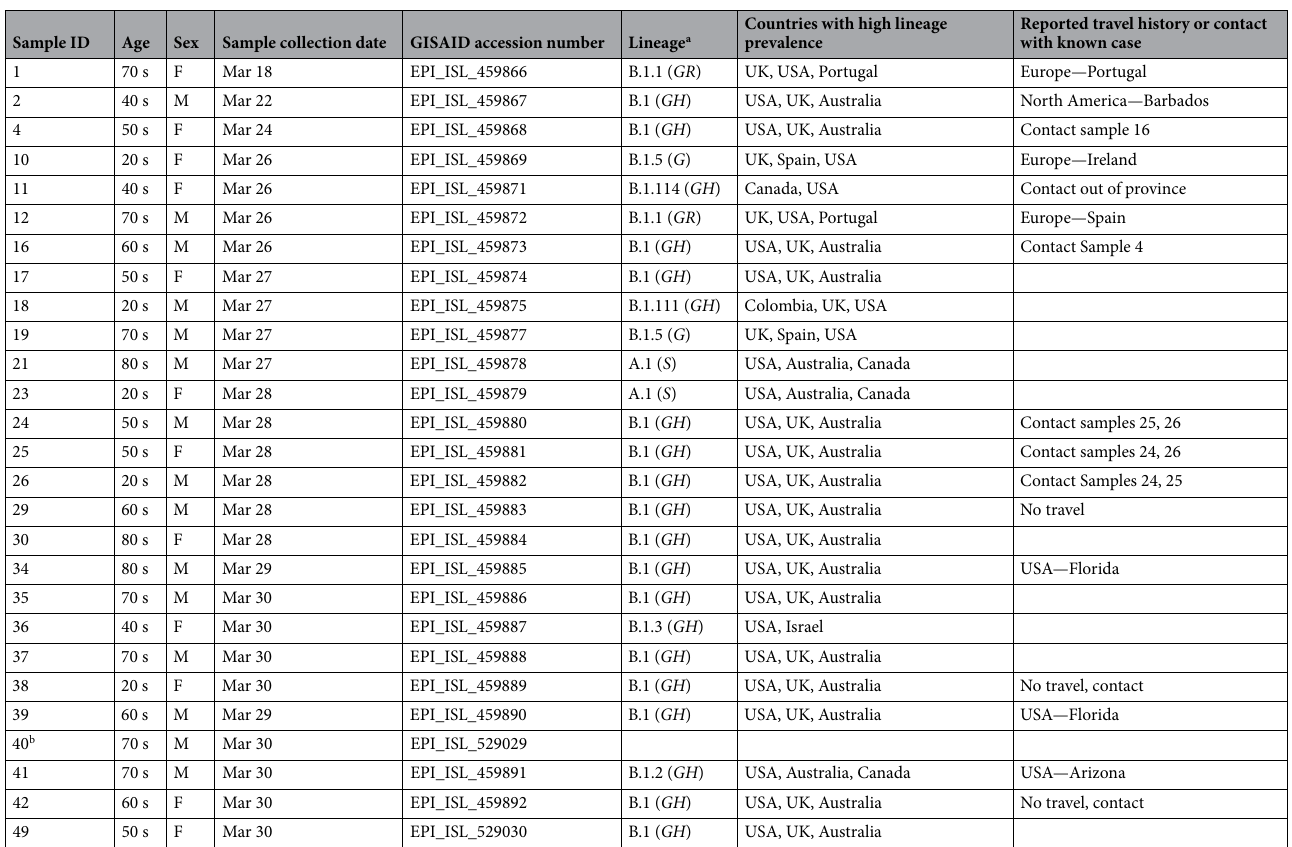
Table 1. Summary of patient demographic data of first COVID-19 cases in the eastern region of the province of Ontario, Canada. Reported data includes anonymized sample ID, age (rounded to the decade), biological sex of the participant, date of sample collection, GISAID accession number for consensus sequence, PANGOLIN lineage ( GISAID Clade ) a , area of the world that have high prevalence of that viral lineage, and source of infection based on patient’s reported travel or contact history. a Lineages assigned by Pangolin COVID-29 Lineage Assigner at https ://pango lin.cog-uk.io/. b Lineage not assigned due to low read coverage around position 14,408, a variant characteristic of B-lineage